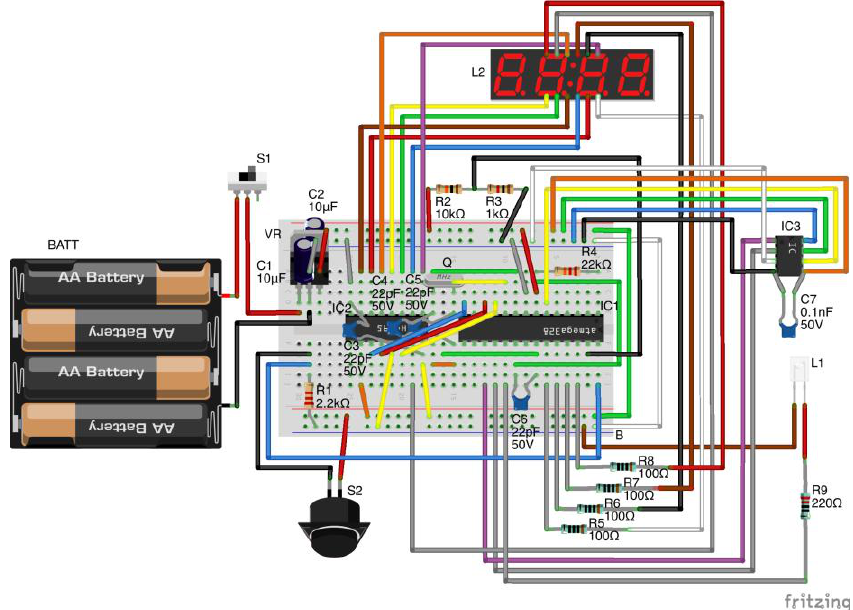
Figure 3. Wiring diagram for the open-source